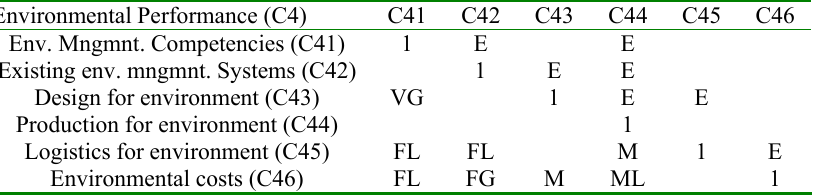
Table 14. Linguistic evaluation matrix of DM1 for C4 sub-criteria